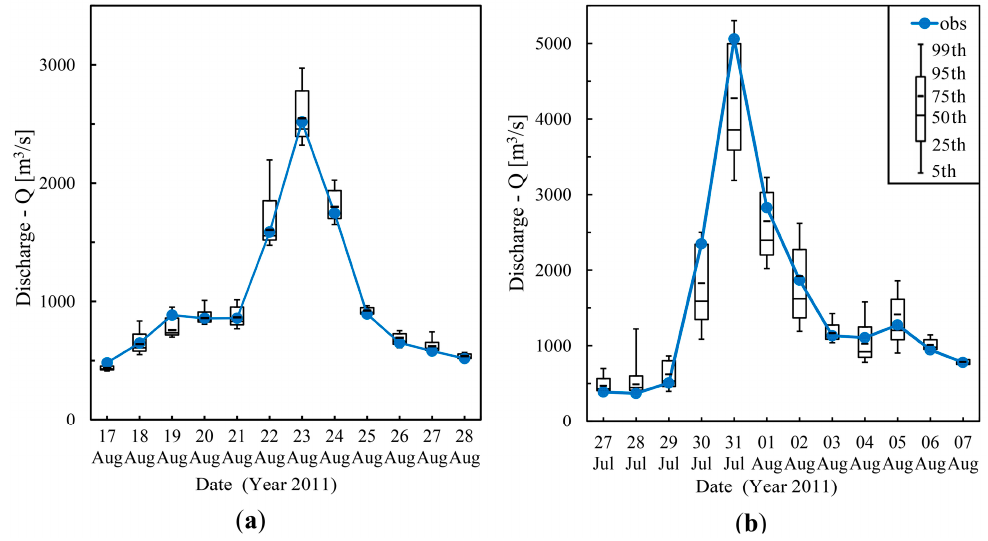
Figure 6. BMA GE percentile forecasts and observed river discharge for two flooding events in the Fu River basin: ( a ) Event I; ( b ) Event II.